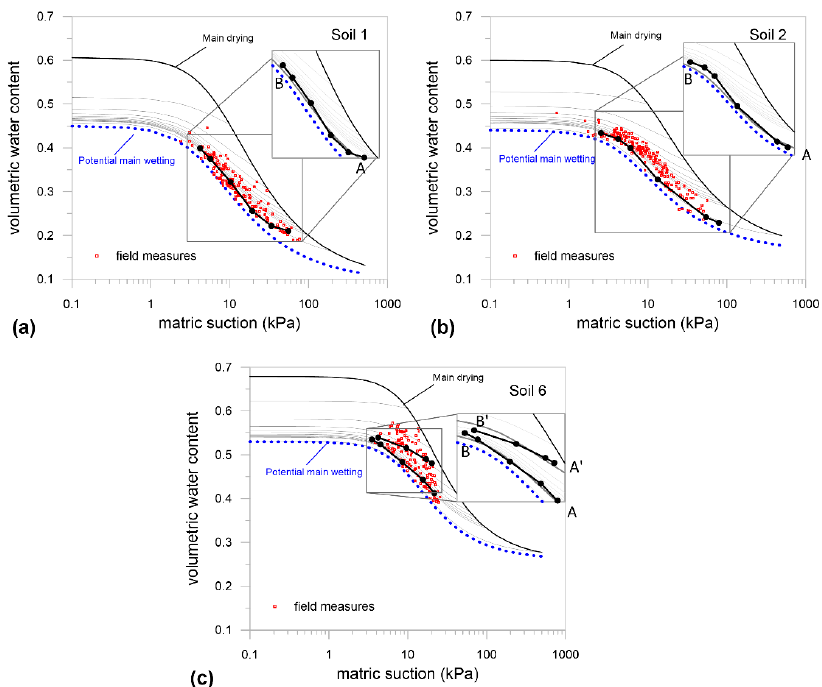
Figure 15. Pairs of matric suction and water content measurements collected at the site in soils 1 ( a ), 2 ( b ), and 6 ( c ) compared to the main loop (continuous and dotted blue lines) and to the secondary wetting paths starting from different points on the main drying curve (gray dotted lines) determined by the LP model. Examples of wetting field paths (circular black symbols connected by black lines) that overlap scanning wetting paths predicted by the LP model (gray dotted lines) are depicted in the zoom.